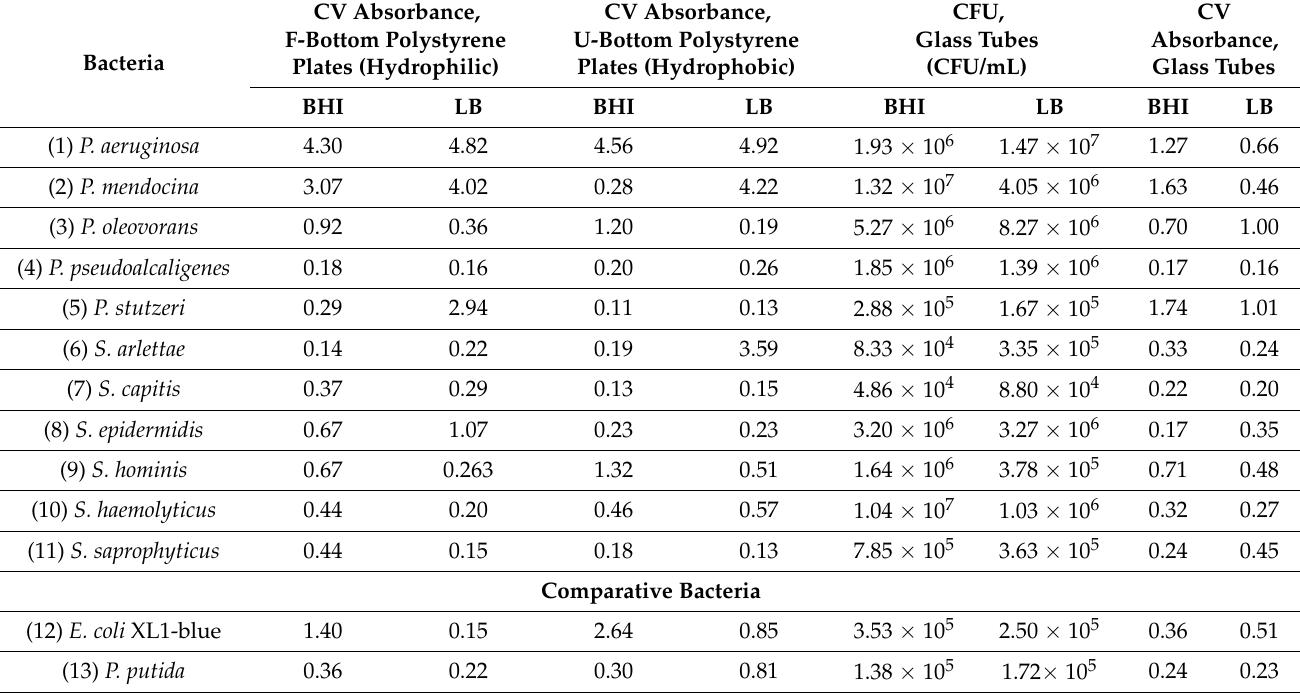
Table 2. Overview of monoculture biofilm formation behavior of different bacterial species using crystal violet (CV) staining on hydrophilic F-bottom polystyrene cell culture plates (CCP), hydrophobic U-bottom 8-strip plates, and glass tubes. Glass tubes were also analyzed by colony-forming unit (CFU) measurement, the average value is shown in CFU/mL. Biofilm formation was conducted with both the brain heart infusion (BHI) medium and on Luria broth (LB) plates.